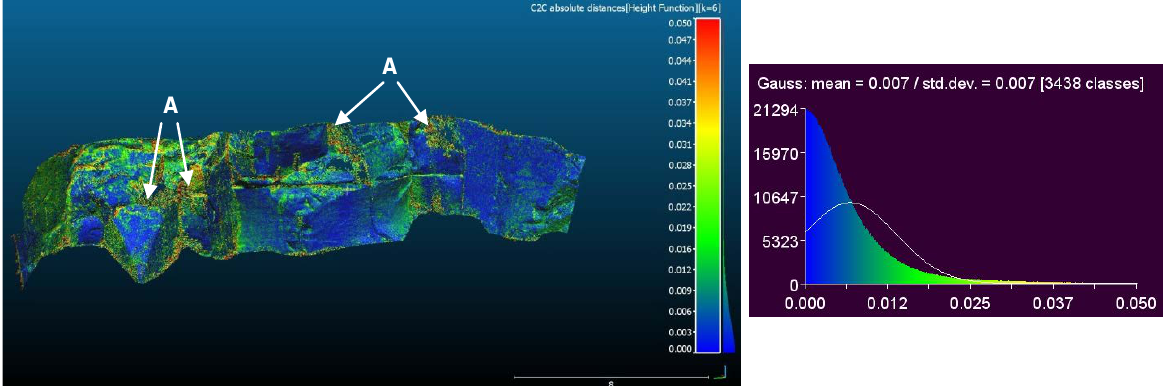
Figure 9. Error mapping of deviation between TLS and Panasonic Lumix ZS20